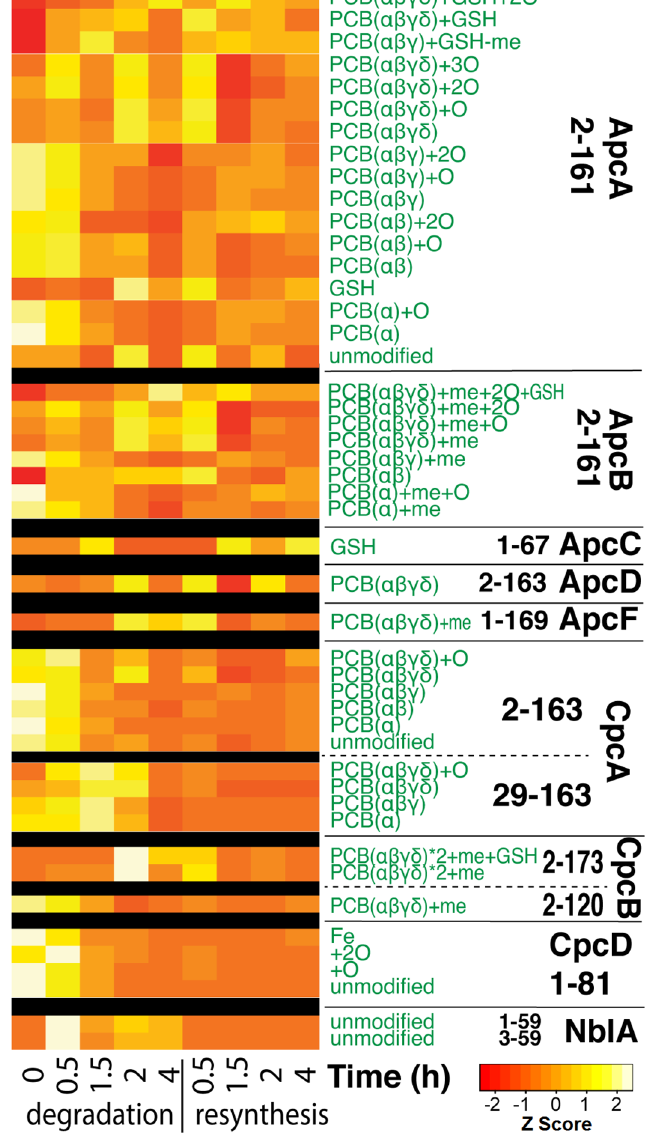
Heatmap showing the relative changes of proteoform abundances of the major phycobiliproteins (PBPs) shown in Figures 3 and 4. Each row represents a proteoform as annotated by the green text, which are grouped by protein. The black text to the right shows the protein name and starting–ending residue numbers. Each column represents the averaged relative abundance of 3 biological replicates at each time point. The color key to the Z score in the heatmap is shown at the lower right bottom.